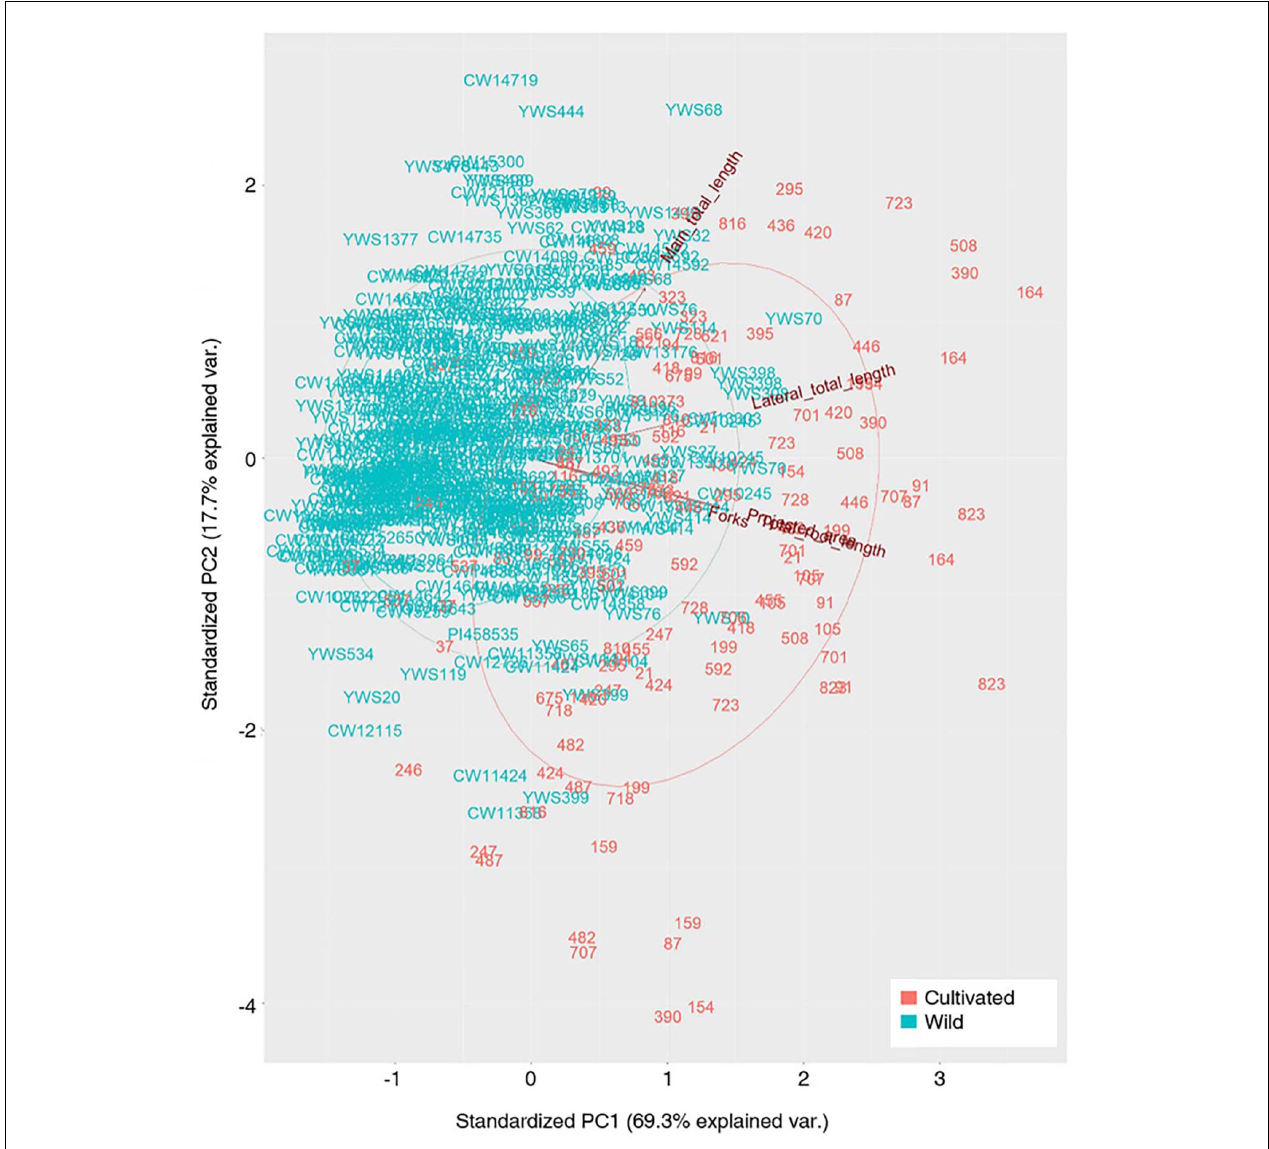
FIGURE 3 | Plot of the first-two PC loading vectors (blue, wild; red,